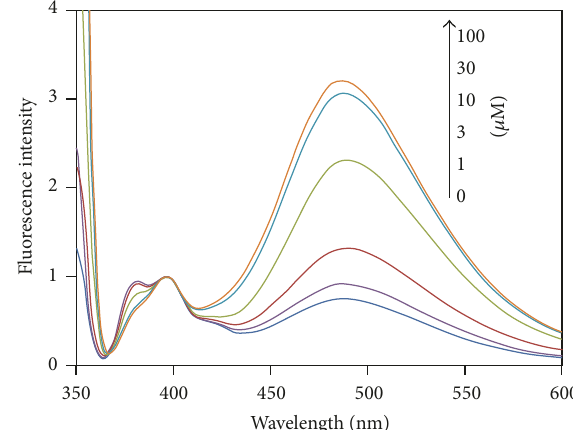
Figure 1: Fluorescence spectra for aqueous solutions of polymer B-11 (1mgL −1 ) buffered at pH 10.9 by 10mM CAPS at various H 2 O 2 concentrations at 25 ∘ C. The spectra are normalized at 397 nm. Excitation: 348 nm.